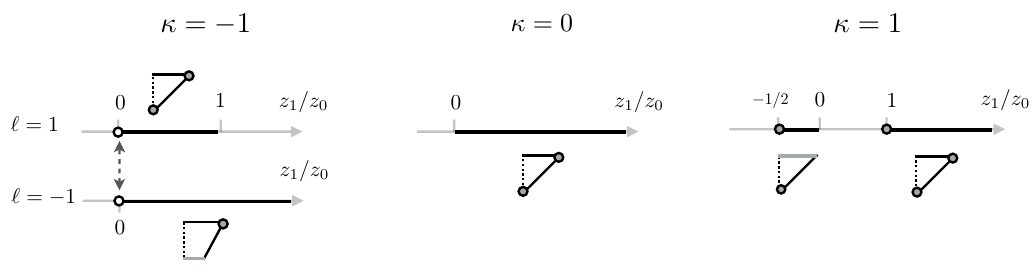
1 ; 1. The cartoons refer to (cid:0)